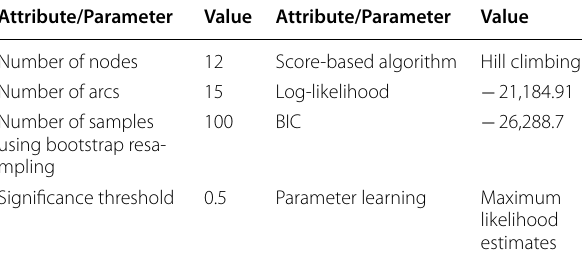
Table 5 Parameters and results of the BN using the hybrid structure‑learning algorithm